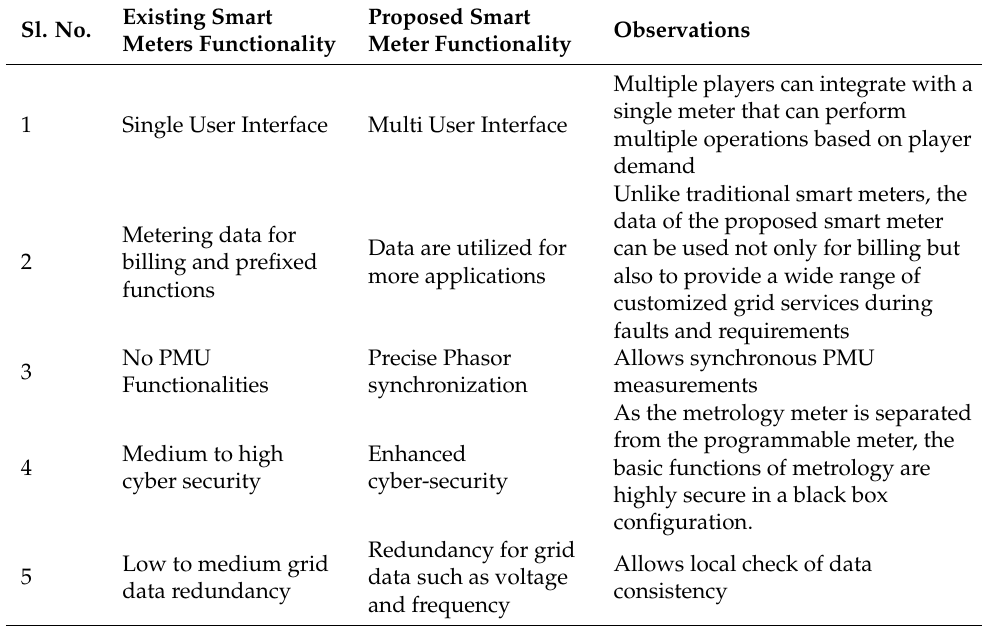
Table 2. Advantages of proposed smart meter over state of art smart